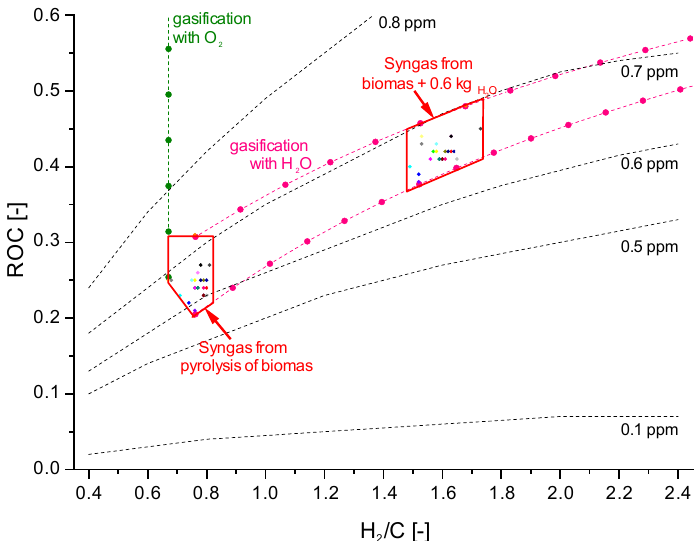
Figure 4. Achievable HCl concentrations after absorption by Na 2 CO 3 at 500 °C, depending on the syngas composition.